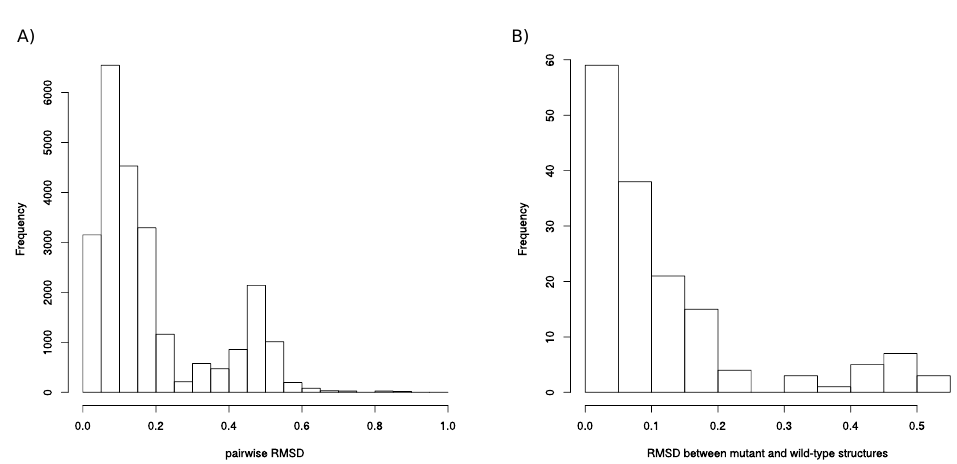
Figure A5. Comparison between pockets. ( A ) Distribution of RMSD computed between all pocket pairs. ( B ) Distribution of RMSD computed between the wild-type and mutant